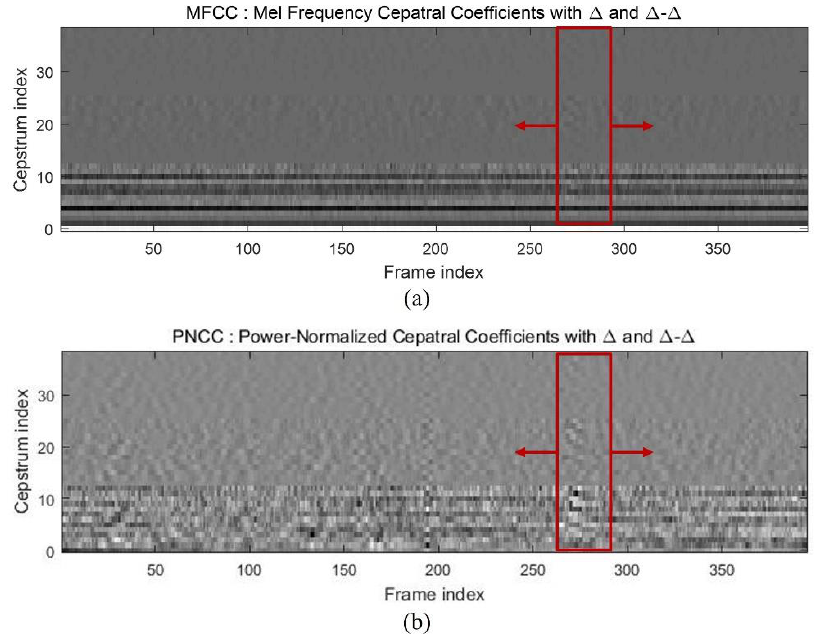
Figure 12. Target data generation of MFCC and PNCC output using data augmentation: ( a ) MFCC data augmentation; ( b ) PNCC data augmentation.